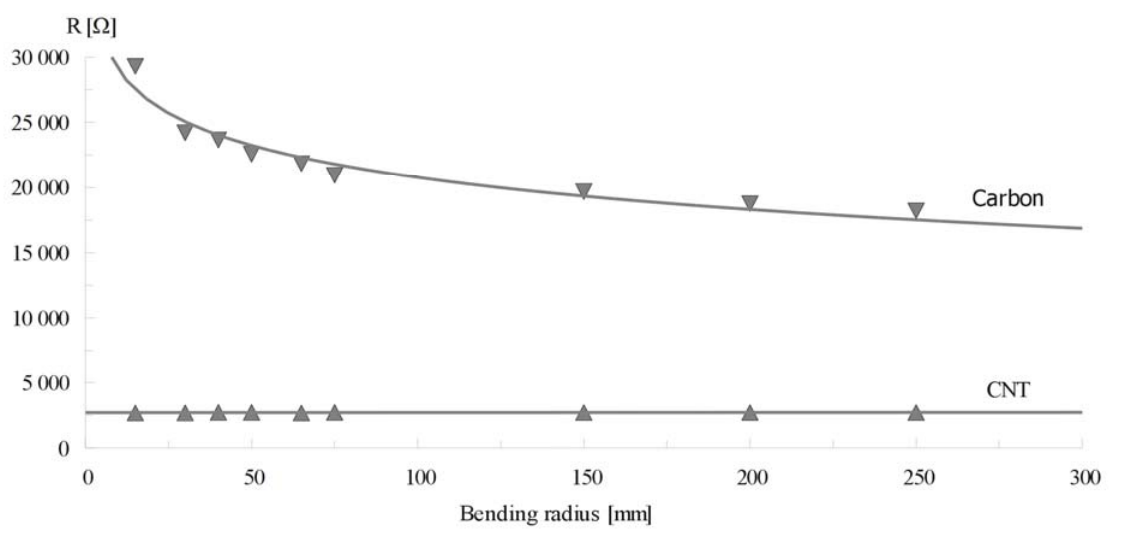
Figure 5. Resistance change of test stripes printed from nanotube-polymer and graphite-polymer compositions during bending